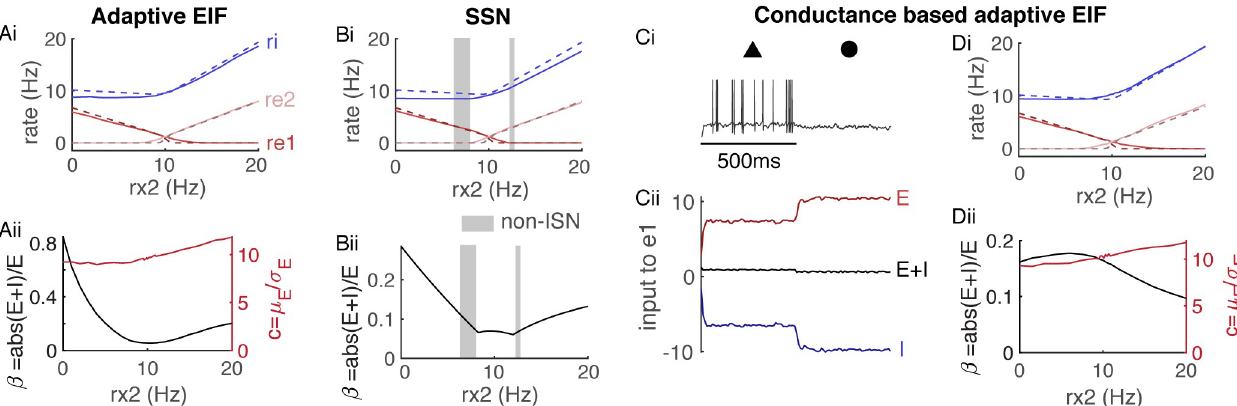
Fig 2. The semi-balanced approximation is accurate across models and dynamical states. Ai ) Firing rates from simulations (solid) and Eq (4) (dashed) as a function of r x 2 when r x 1 = 10Hz for the same model as in Fig 1E and 1F. Aii ) Balance ratio, β (black), and coupling strength coefficient, c (red), averaged across all neurons from the simulation in Ai. Bi-ii ) Same as Ai and Aii, but using dynamical rate equations that implement a supralinear stabilized network (SSN). Gray shaded areas are states in which the network is not inhibitory stabilized. Ci–ii ) Same as Fig 1E except using a conductance-based model of synapses. Di- ii ) Same as Ai-ii except using a conductance-based model of synapses. All currents are normalized by the neurons’ rheobase.